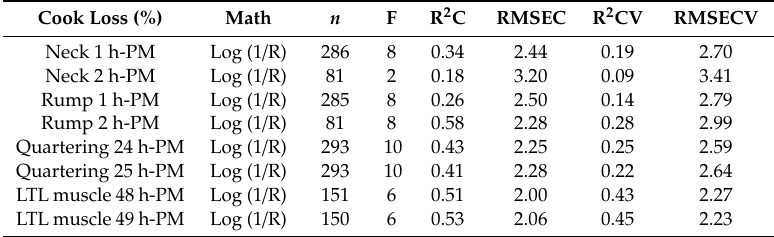
Table 4. Prediction of cook loss (%) of beef samples using Vis–NIR spectra.